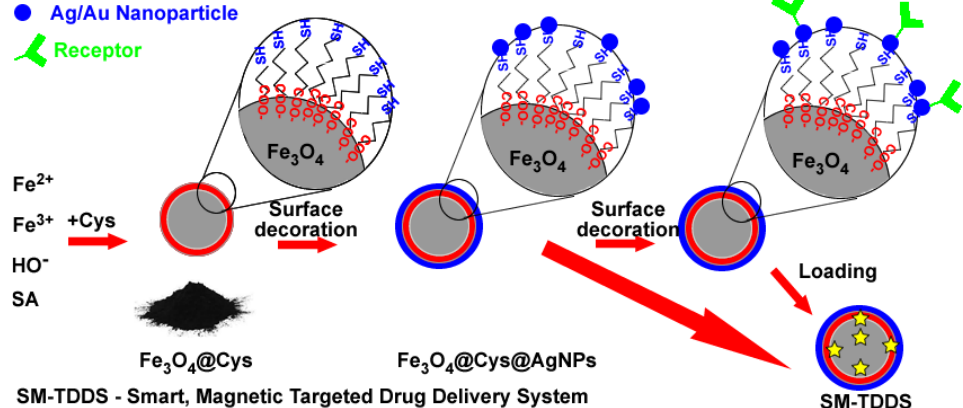
Figure 6. Smart MNP with triggered delivery and targeted capacity [96].